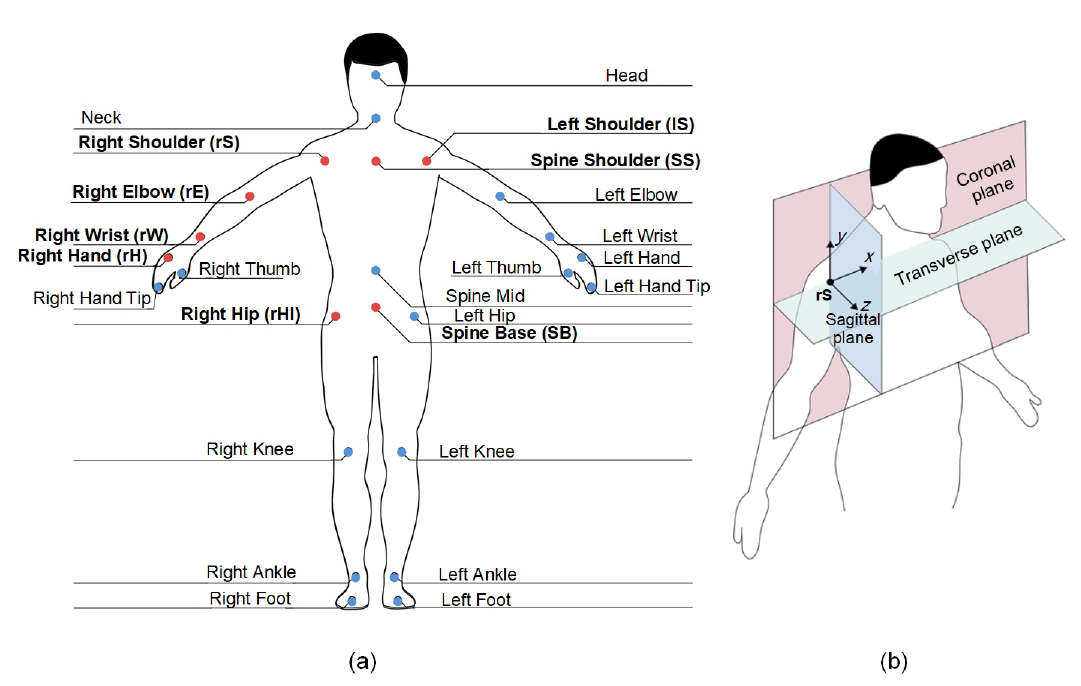
Figure 4. ( a ) The twenty five skeleton joints that are tracked by the Kinect for Windows v2 sensor. ( b ) The body-attached coordinate system of the Extended Motion-Pose Geometric Descriptor